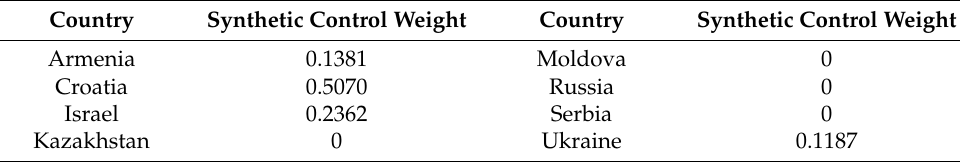
Table 1. Synthetic weights for the European Union (EU)-8.